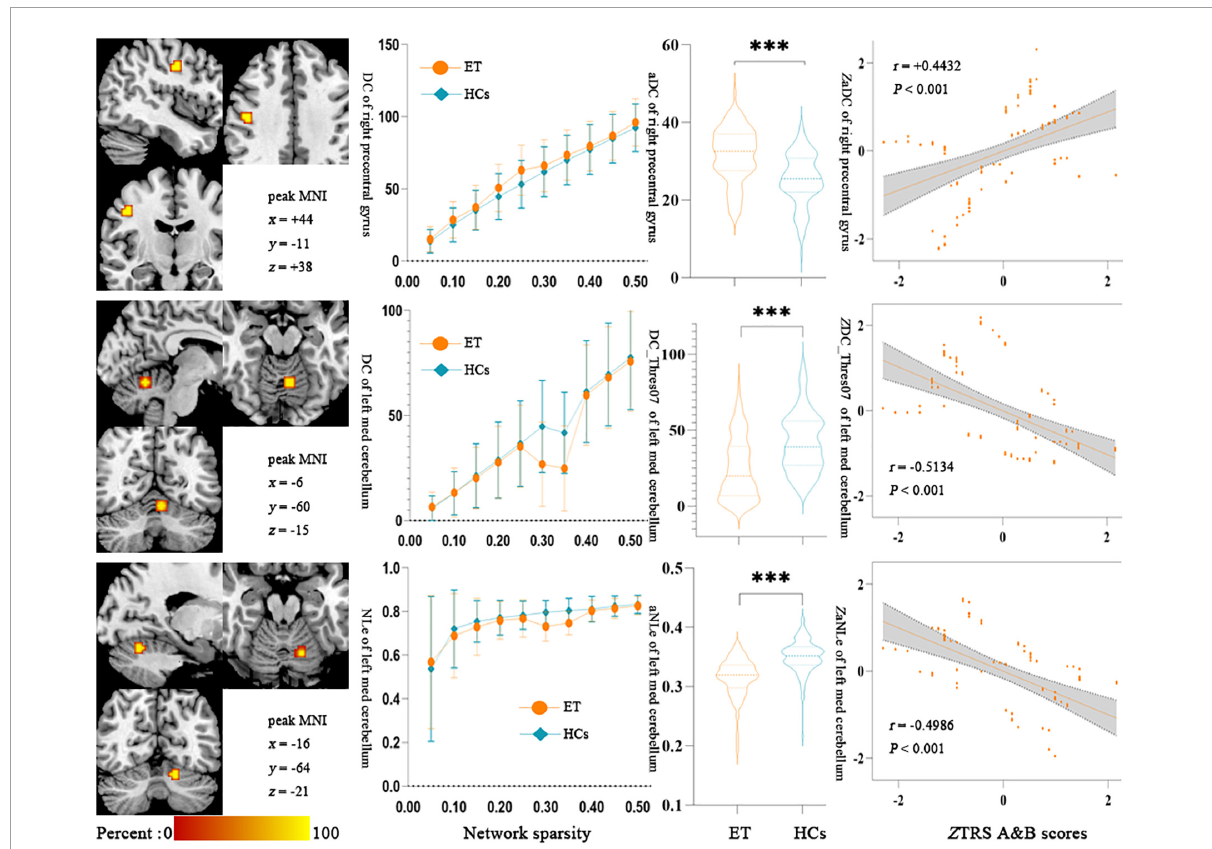
FIGURE4 Results of Partial Pearson correlation analysis between the topologic metrics values of significant discriminative features and the TRS A&B scores in ET patients. Bonferroni multiple comparison corrections, corrected P < 0.05/20*(20–1)/2. (Left) The cluster of the significant discriminative features. (Middle) Mean and standard deviations of the significant discriminative features across subject groups (orange-ET, green-HCs) as a function of network sparsity and the mean topologic metric values of significant discriminative features with group differences across the sparsity from 0.05 to 0.50 between ET patients and HCs. *** P < 0.001. (Right) Scatterplots for the correlation analysis in patients with ET. NLe, nodal local efficiency; DC, degree centrality; zNLe, z-transformed nodal local efficiency; zDC, z-transformed nodal degree centrality; Thres07, the threshold of 0.35; aDC, the AUC values of degree centrality; zTRS A&B scores, z-transformed Fahn-Tolosa-Marin Tremor Rating Scale parts A and B scores; ET, essential tremor; HCs, healthy